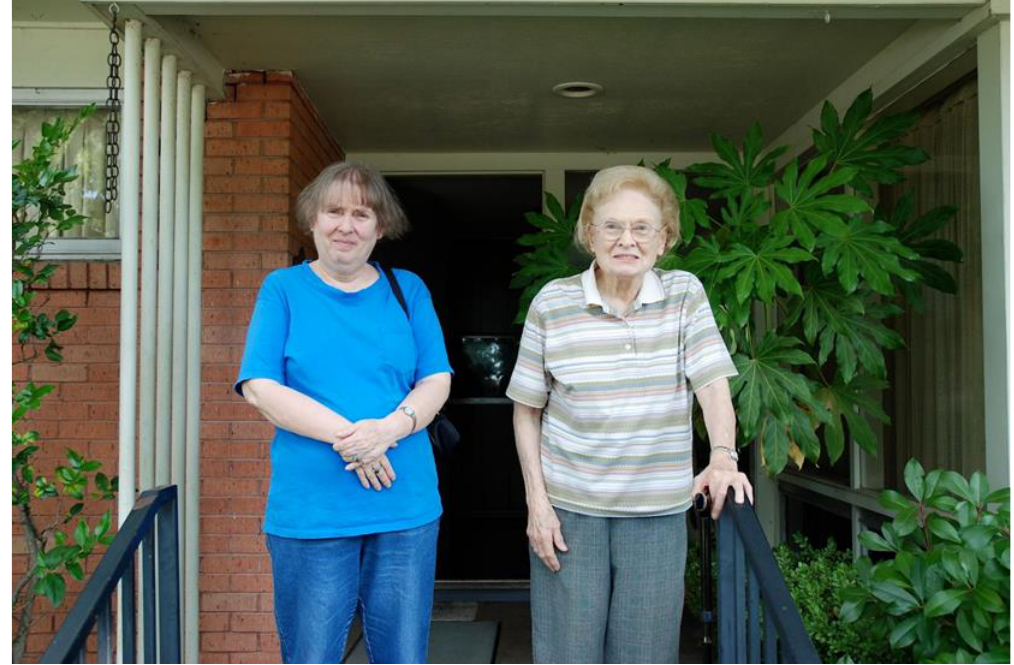
Figure 6: Dona and Mimi in front of their house in Dallas, Texas. Courtesy: Sophie Sartain CV: The protagonists in the film are deepened and narrativized in their complexity: e.g., your mother (also for you) becomes a sibling that has a hard time living with a sister like Dona and moves out of the house; Mimi becomes a woman who makes her own dresses and likes dancing. Dona, however, apart from transitioning and adjusting to institutional life and dramatically changing through Alzheimer’s disease, stays rather flat and